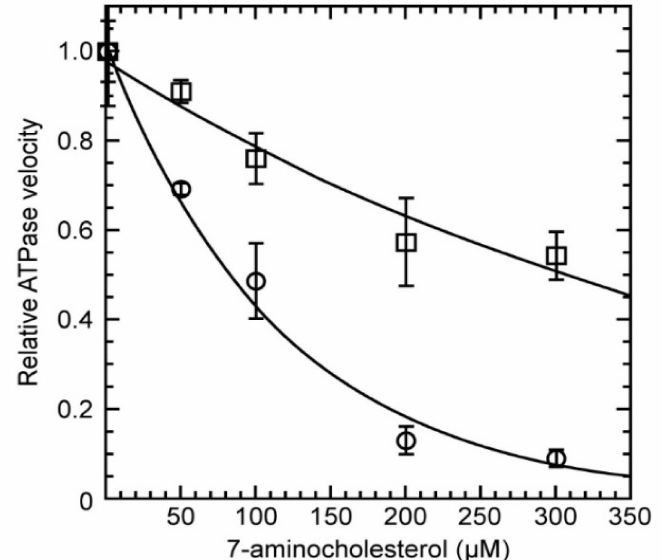
Figure 3. Relative ATPase reaction rates of the two proteins in the presence of increasing concentra- tions of 7- α -aminocholesterol and 340 ng/ µ L RNA. Mammalian eIF4AI was used at 1200 nM and Molecules 2022 , 27 , x FOR PEER REVIEW 8 of 18 LieIF4A at 820 nM. The error bars represent the mean and standard deviations of three independent measurements made. The relative reaction velocities were normalized to one in the absence of the inhibitor compound to facilitate comparisons. Data were fit to an exponential decay for visualization purposes and IC 50 calculation. The relative reaction rate of LieIF4A ( ◌ ) and eIF4A Mus ( □ ) were plotted as a function of compound concentrations. The 7- α -aminocholesterol had different kinetic effects on the two proteins and clearly showed stronger inhibition on the Leishmania protein.